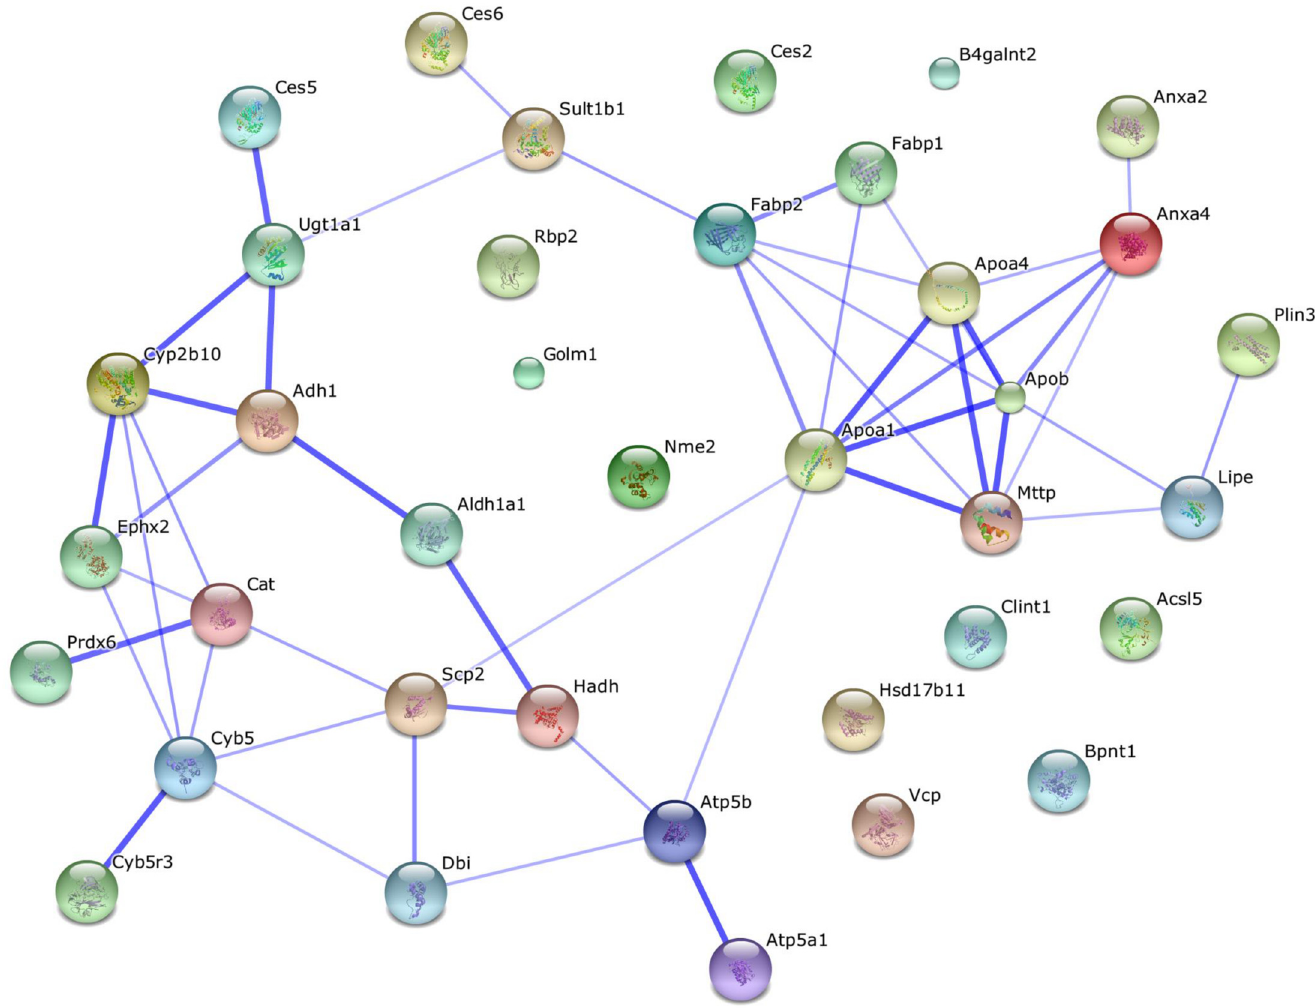
Fig 4. Lipid related proteins identified cluster based on predicted physical and functional interactions. A STRING analysis was conducted to map predicted interactions of lipid related proteins. The resulting network shows several clusters, including proteins responsible for lipoprotein synthesis and modifiers of fatty